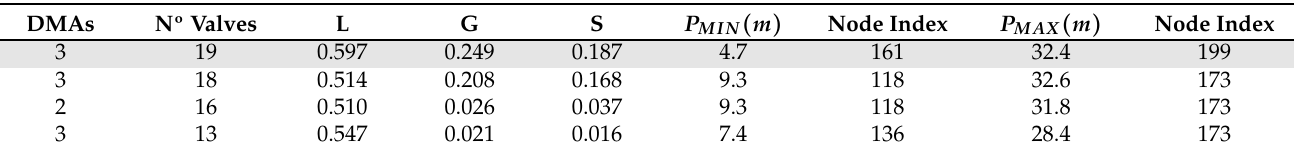
Figure 7. Demand distribution per DMA for solution A, B and C for TRN network. Colors code corresponding to DMAs of Figure 6. Table 1. Operating conditions of each solution obtained with Standard deviation for TRN network. The gray background corresponds to the solution A represented in Figure 6.